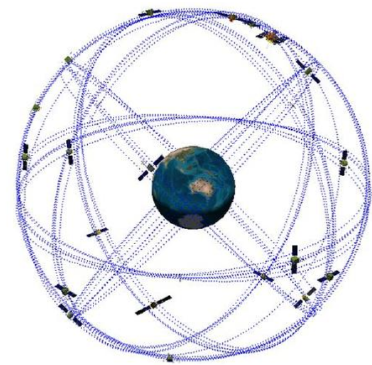
Figure 2. Deployment of GPS satellites: they are evenly distributed on six orbital planes and continuously transmit GPS signals.